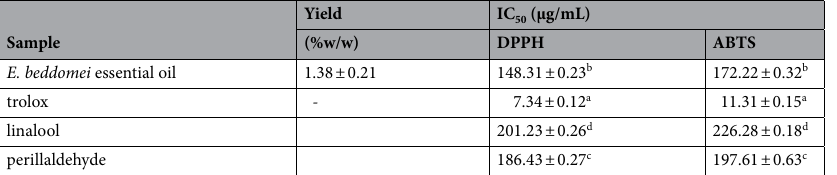
Table 2. Antioxidant activities of essential oil and standards. The data are mean ± standard deviation. Different letters indicate significant differences ( p < 0.05).